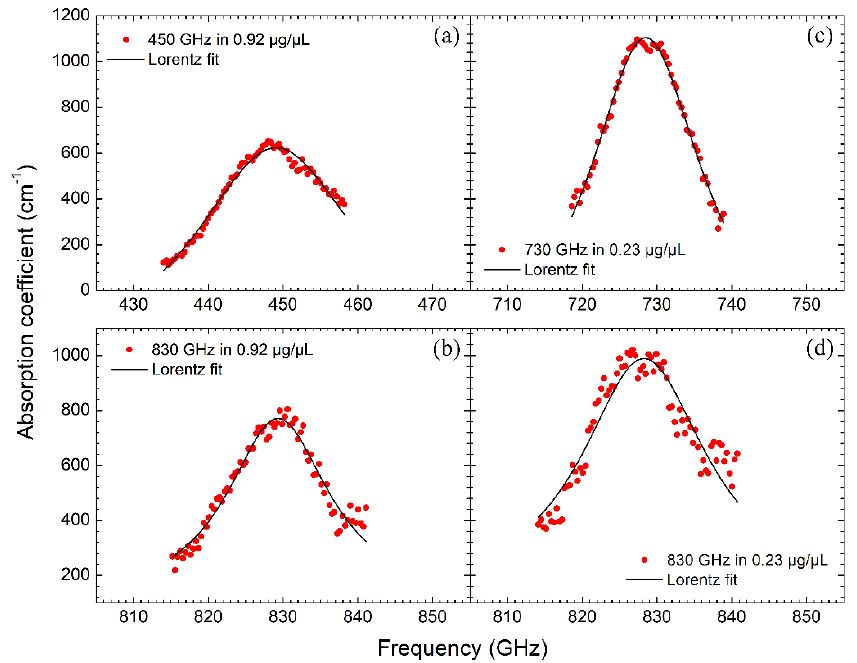
Figure 4. The fitting of absorption coefficients around the attenuated signals with the Lorentz function, ( a , b ) represent the 450 and 830 GHz attenuations at 0.92 μg/μL, ( c , d ) represent the 730 and 830 GHz attenuations at 0.23 μg/μL. Table 1 . The fitting parameters of each Lorentz curve in Figure 4